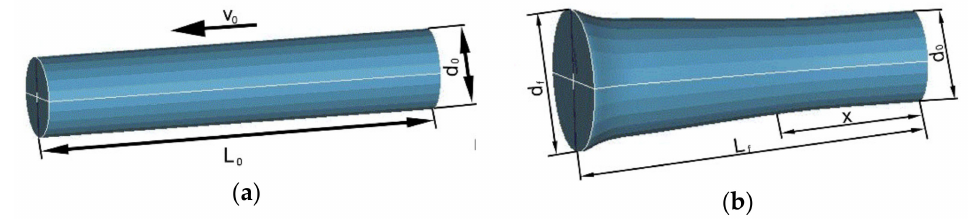
Figure 1. Depiction of TAT testing specimen: before TAT ( a ); after TAT ( b